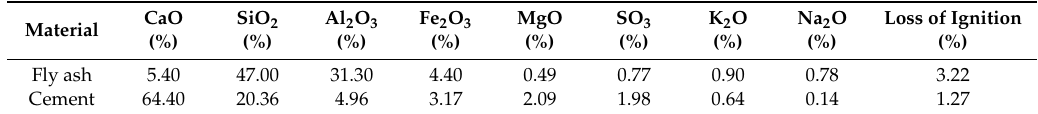
Table 3. Chemical compositions of fly ash and cement.